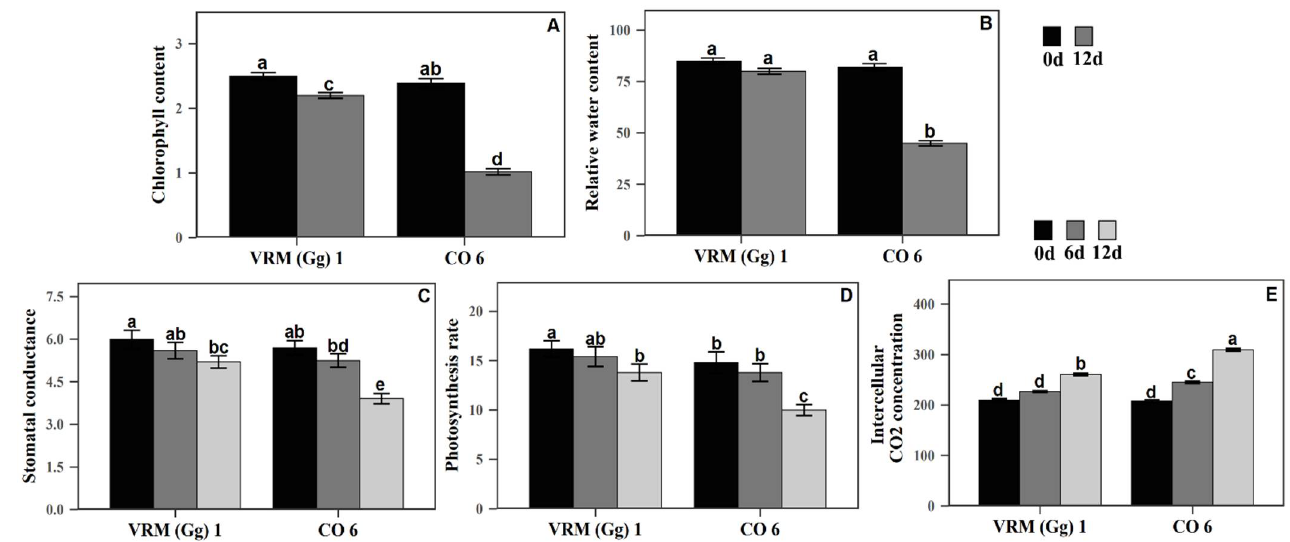
Figure 1. ( A ) Chlorophyll content (mg g −1 FW), ( B ) relative water content (%), ( C ) stomatal conductance (mol H 2 O m −2 s −1 ), ( D ) photosynthesis rate (µmol CO 2 m −2 s −1 ), and ( E ) intercellular CO 2 concentration (ppm) of two mungbean cultivars (VRM (Gg) 1 and CO6) grown under control and drought-stressed conditions. Values followed by the same letter are not significantly different ( p ≤ 0.05) according to duncan’s multiple range test. Bars present means ± SE ( n = 3).